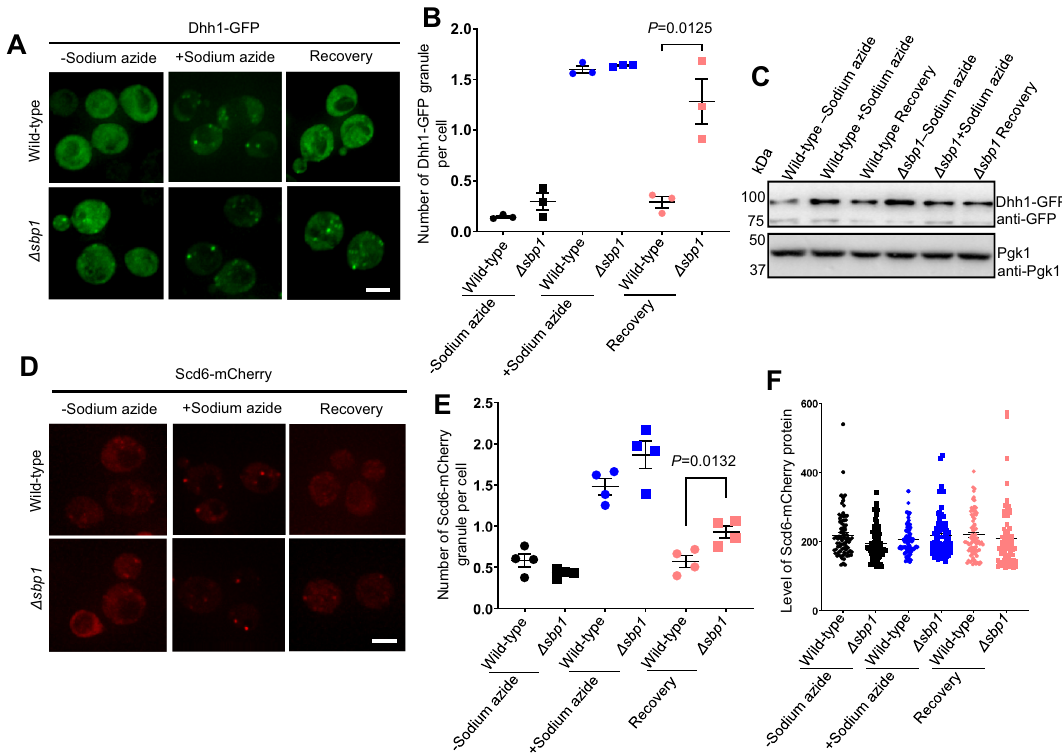
Fig. 2 Disassembly of other P-body markers is defective in absence of Sbp1. A Live-cell microscopy to observe disassembly of Dhh1-GFP as P-body marker. Scale Bar, 3 µ m. B Graph depicting the number of Dhh1-GFP foci per cell in wild-type and Δ sbp1 strain. Data plots represent mean ± SEM from of n = 3, where ‘ n ’ represents number of independent experiments. A two-tailed paired student t -test was used to calculate P -values. C Dhh1-GFP protein level during unstress, stress and recovery in wild-type and Δ sbp1 strain. D Live-cell microscopy to observe disassembly of Scd6-mCherry as P-body marker. Scale Bar, 3 µ m. E Graph depicting the number of Scd6-mCherry foci per cell in wild-type and Δ sbp1 strain. Data plots represent mean ± SEM from of n = 4, where ‘ n ’ represents number of independent experiments. A two-tailed paired student t -test was used to calculate P -values. F Protein level of Scd6-mCherry during unstress, stress, and recovery in wild-type and Δ sbp1 strain based on the measurement of mCherry signal using microscopy. Data plots represent mean ± SEM from of n = 3, where ‘ n ’ represents number of independent experiments. A two-tailed paired student t -test was used to calculate P